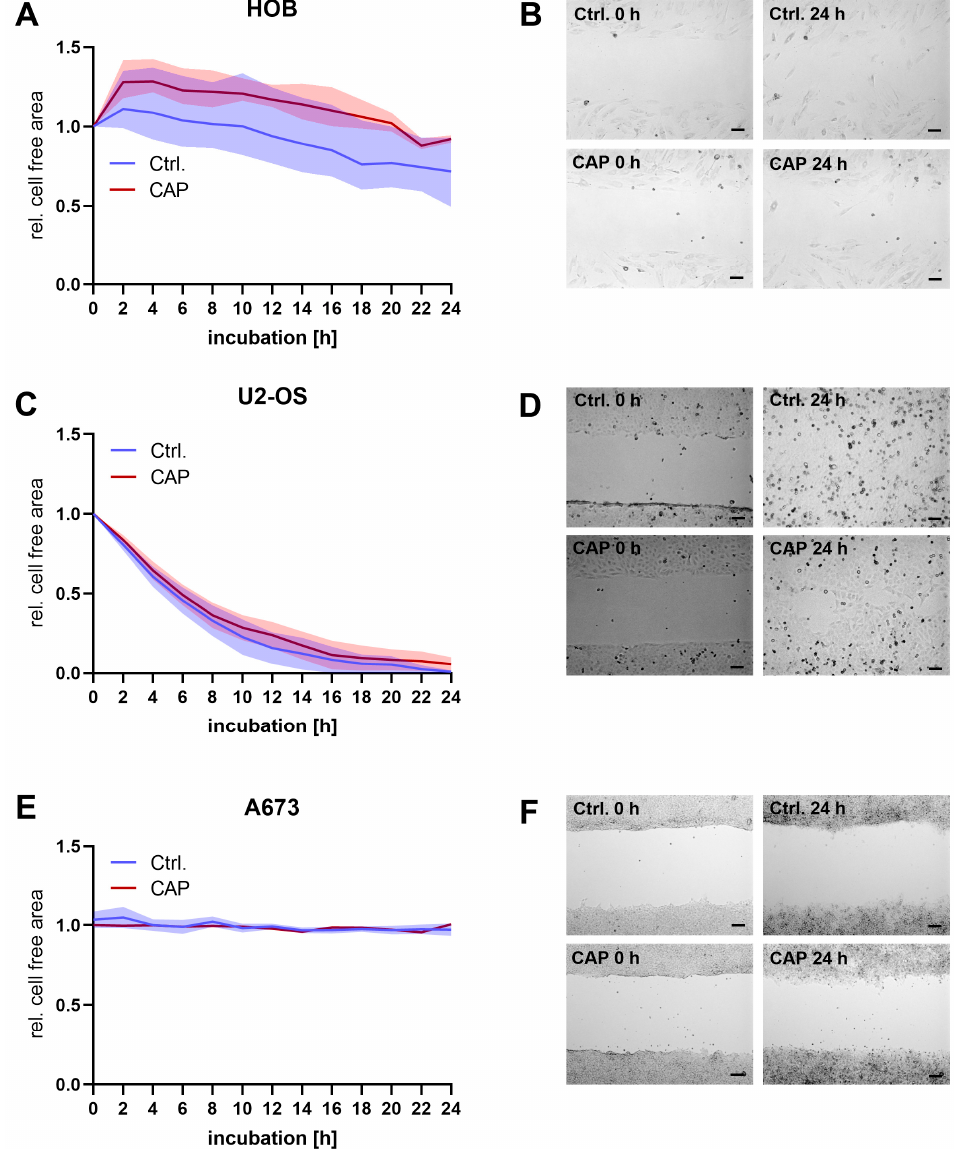
Figure 5. Human osteoblasts (HOB) and bone cancer cells (U2-OS and A673) were incubated in two-well cell culture inserts. After the removal of the insert, cells were treated with cold atmospheric plasma (CAP) or argon-treated medium. The cell-free area was recorded over 24 h in intervals of 2 h ( A , C , E ). The quantified cell-free areas were normalized to the cell-free area at the beginning of the experiment. ( B , D , F ): show representative images. Scale indicator is 100 µm. Data were shown as mean with range.